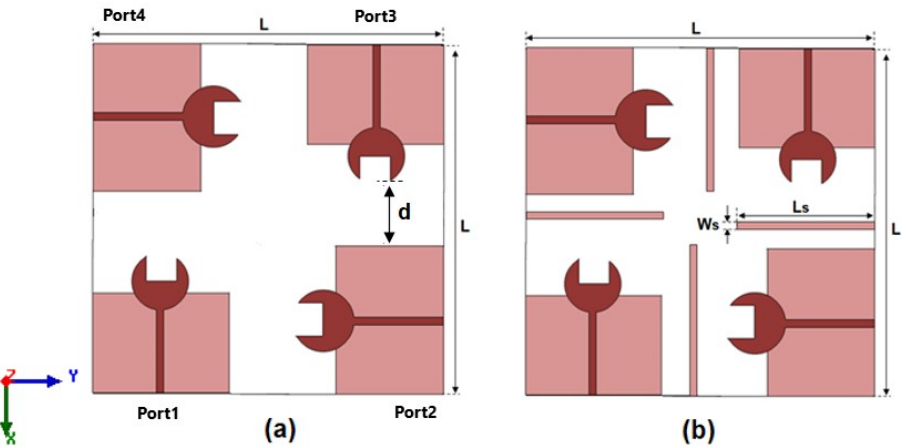
Figure 5. The 2D configuration of the 4-port MIMO antenna ( a ) without stubs and ( b ) with stubs.